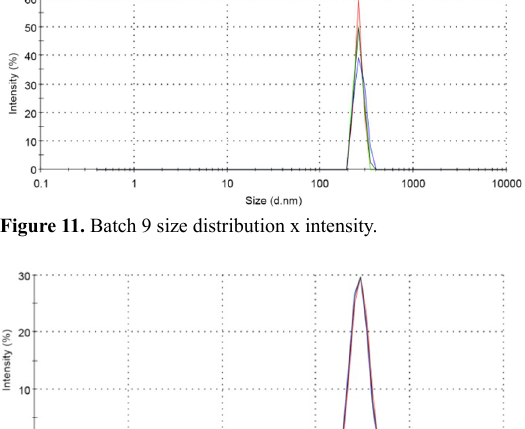
of PCN formation mechanism as well as included more suitable options to improve the system stabilization such as copolymer addition.